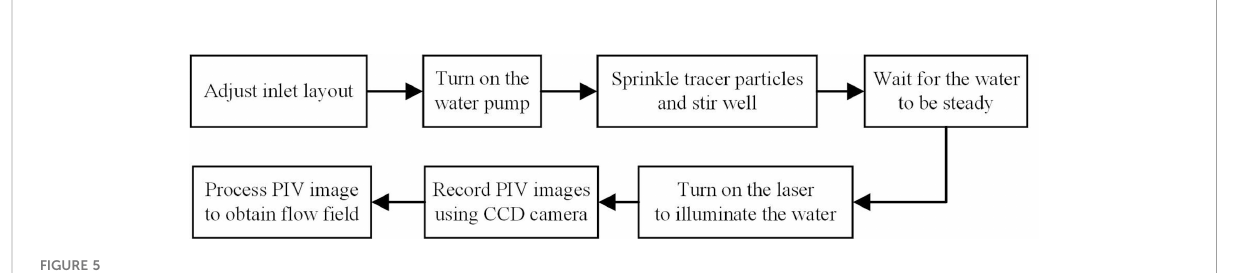
FIGURE 5 Flowchart of the fl ow fi eld measurement